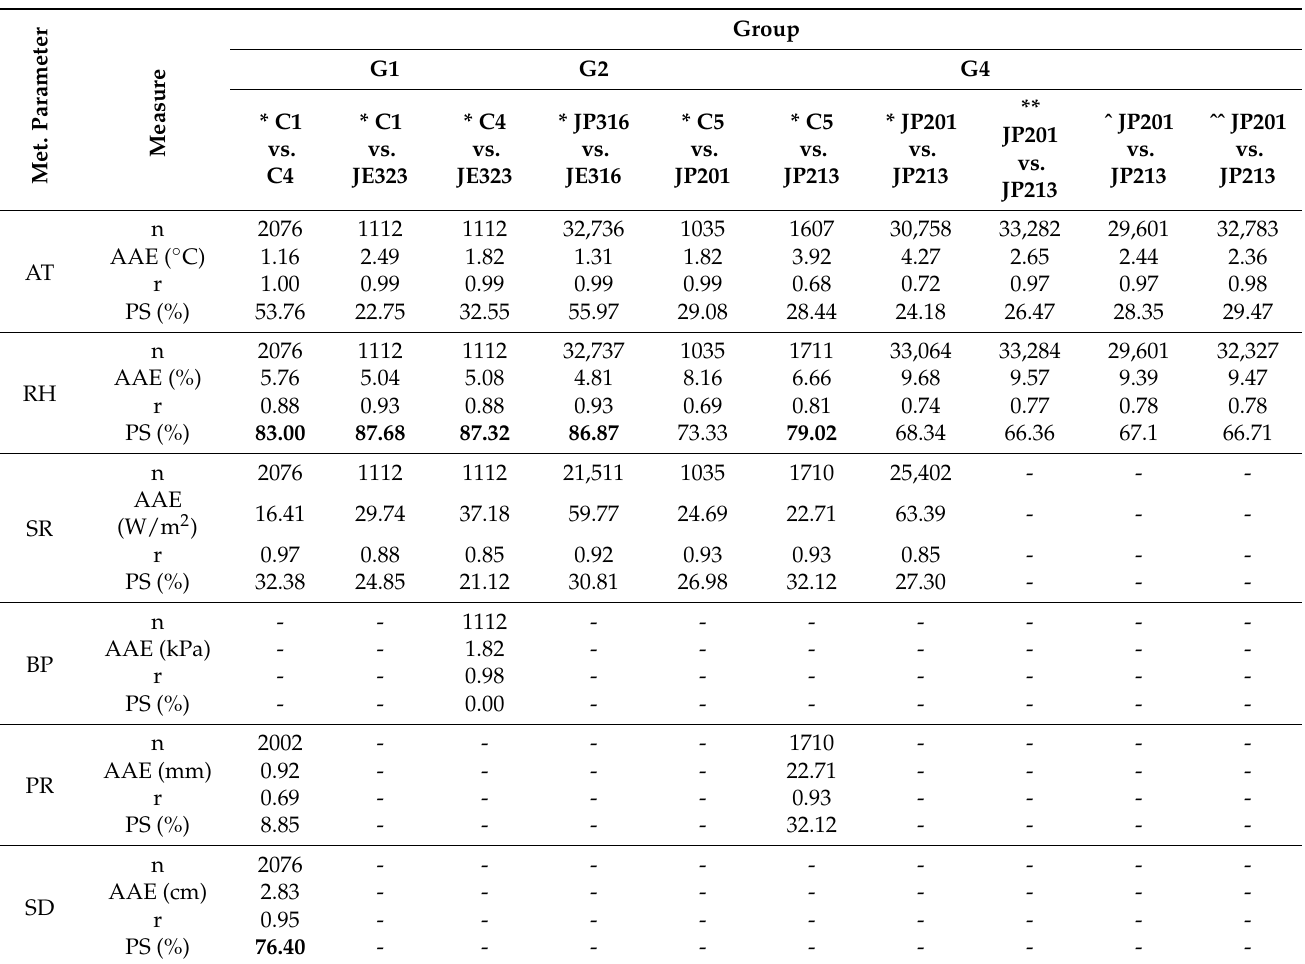
Table 2. Analysis of similarity and relations among the meteorological parameters for G1, G2, and G4 groups. The sign ‘-’ means the measurements were unavailable for comparison, and highlighted bold values mean strong PS with ≥